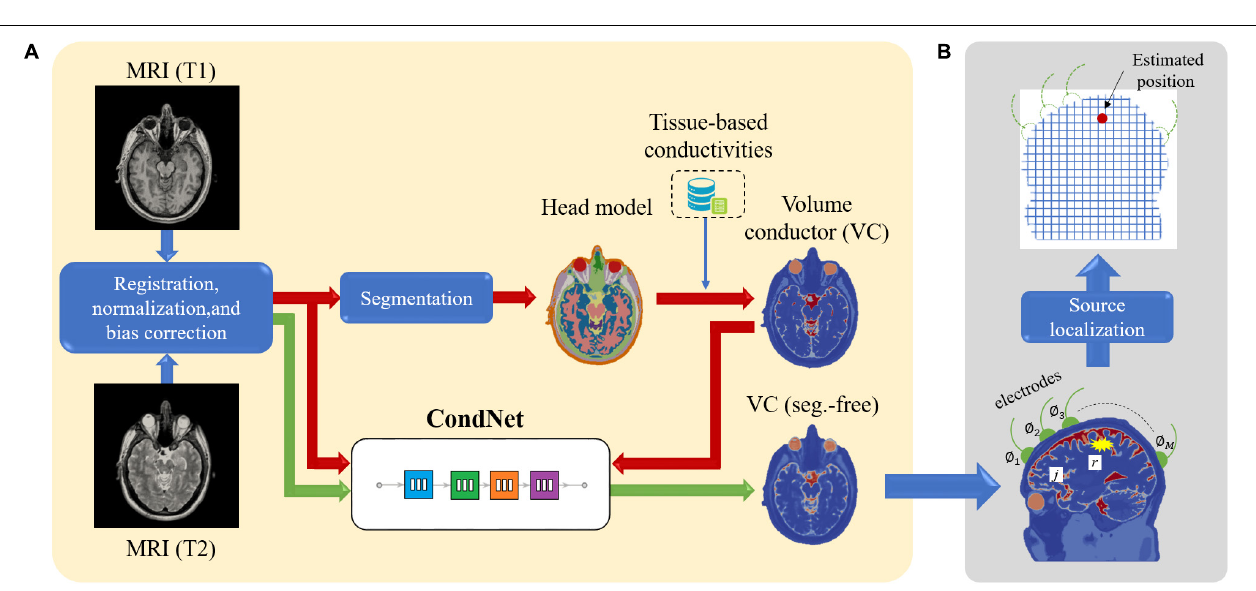
FIGURE 1 | Volume rendering of numerical head models generated for single subject: (A) anatomical segmentation of MRI for 14 different tissues, (B) homogeneous model, (C) homogenous model with CSF-insert, and (D) deep-learning-estimated model (segmentation free). The resolution is 0.5 mm × 0.5 mm × 0.5 mm, and the number of voxels is 27,197,601 for all models.